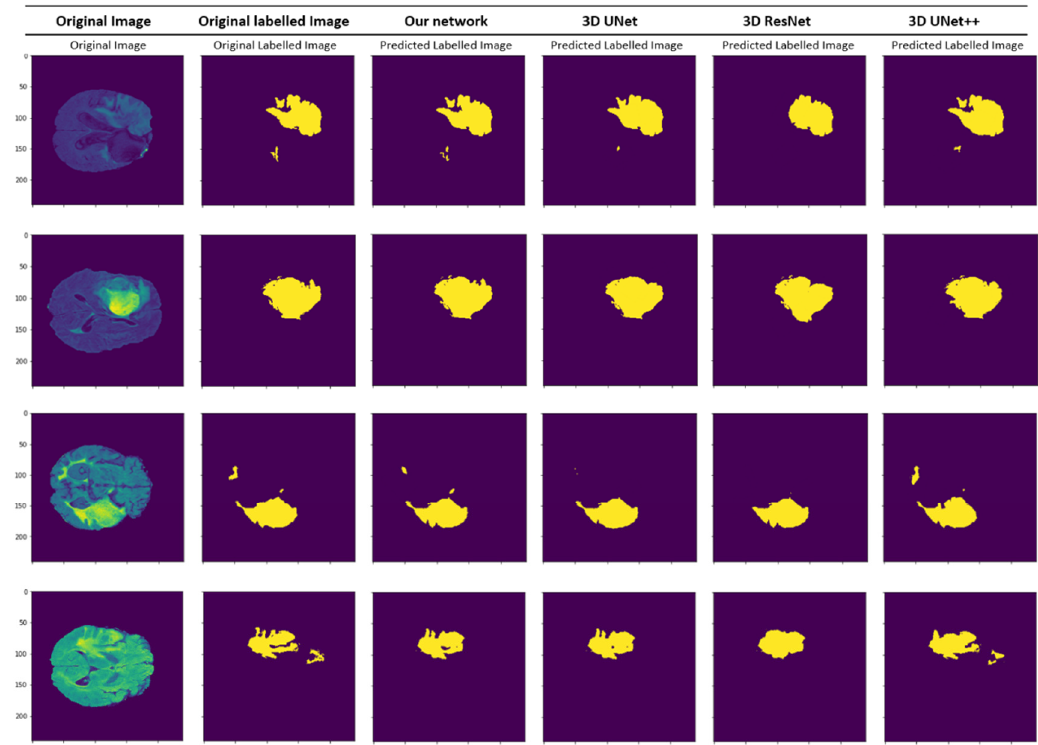
Figure 10. Qualitative segmentation results of various models on the BRATS-2020 dataset. Experimental results show that our method produces better segmentation masks than other state-of-the-art networks.